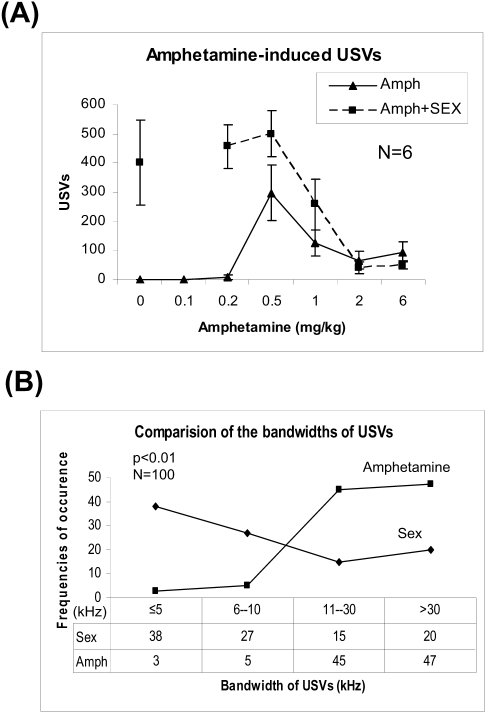
Amphetamine administration dose-dependently stimulated USV production in isolated male mice, and altered the USVs produced during male-female interaction in Exp. 5.(A) D-amphetamine sulfate was given to the mice at 0.1, 0.2, 0.5, 1.0, 2.0 and 6 mg/kg (i.p.), respectively. Amphetamine only stimulated spontaneous USV production in male wild-type mice (CD1x129) (triangles). D-amphetamine sulfate (0.2, 0.5, 1.0, 2.0, 6 mg/kg, i.p.) did not induce USVs in isolated female or M5 KO mice (since no USV was induced, related data were omitted). As compared with saline injection on test day 1, during male-female interaction, male mice produced fewer USVs after 2 or 6 mg/kg amphetamine injection (i.p.) in males (squares, p<0.05). (B) Comparison of bandwidths of sex- and amphetamine-induced USVs in males. One hundred of USVs were randomly selected from large scale of USVs induced by sex and amphetamine (5 mg/kg), respectively. Bandwidths were obtained by measuring the upper frequencies and lower frequencies with Avisoft SASLab Pro software according to the instruction. Amphetamine apparently induced more frequency-modulated USVs (bandwidth >5-kHz) than sex (p<0.01, χ-test). Amph = amphetamine.